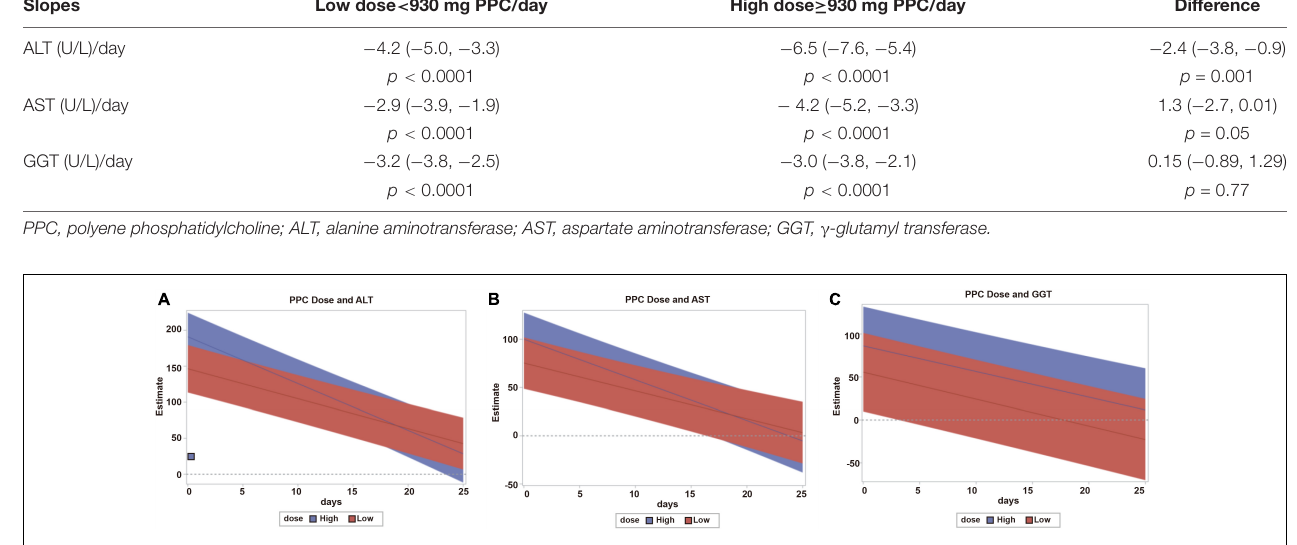
healthcare (15, 16). This provides valuable data on